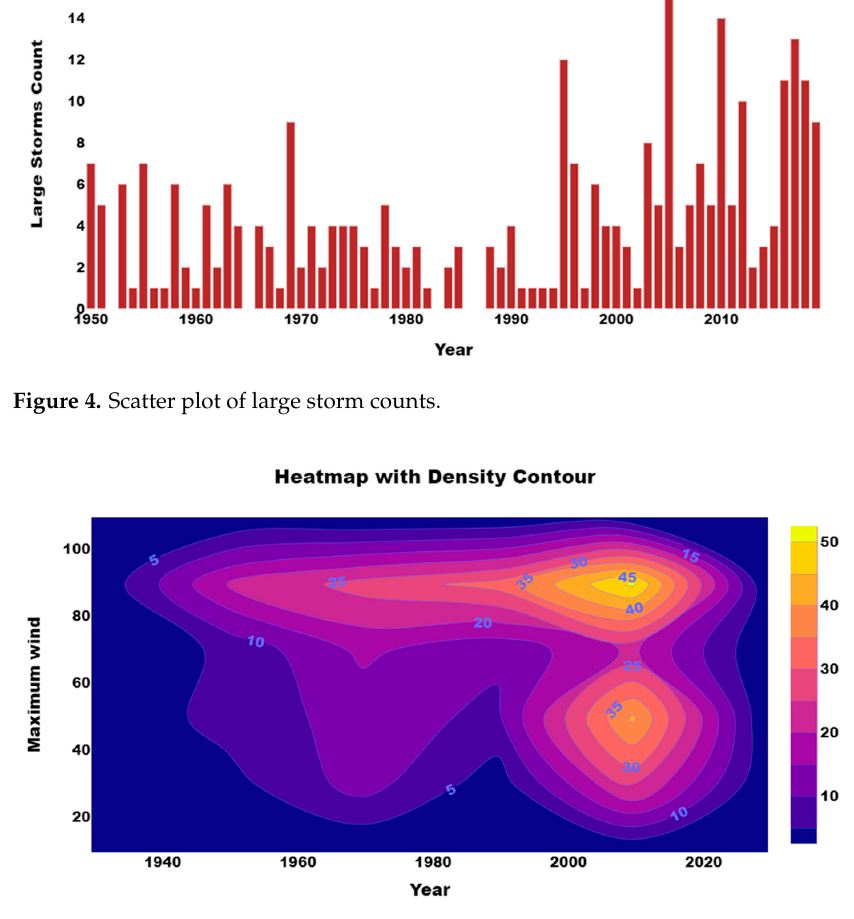
Figure 5. Density contour heat map.